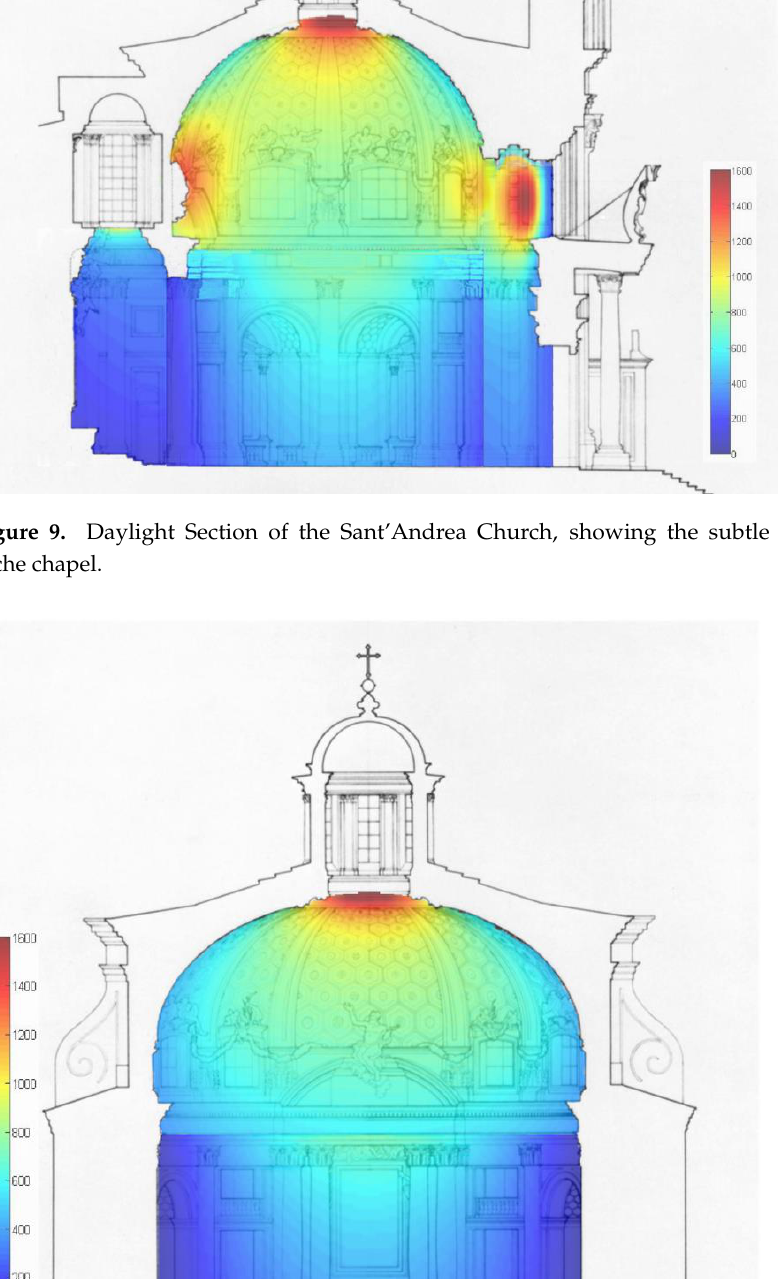
Figure 11. Distribution of light in the plan, showing the contrast between the central space and the chapels.